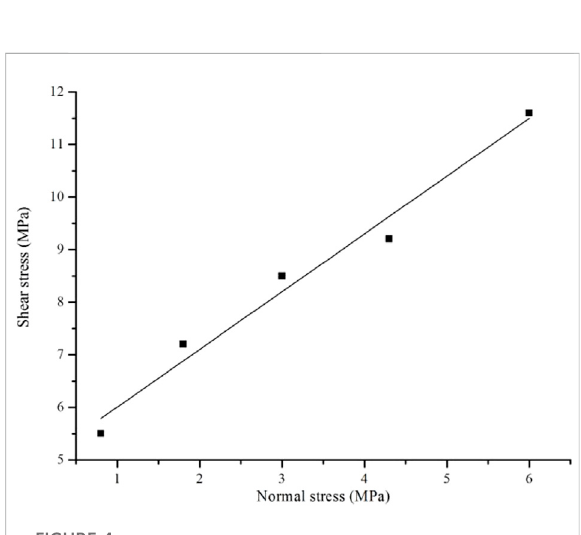
FIGURE 3 Direct shear test equipment picture.